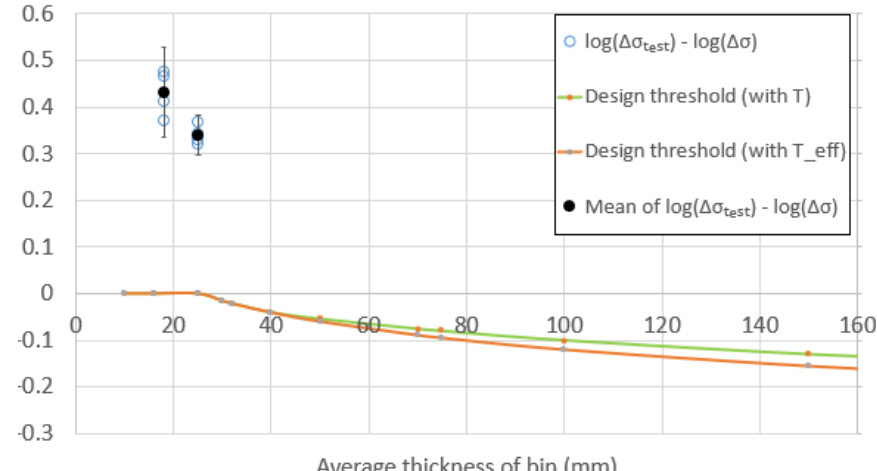
Figure 18. Data analysis of FC transverse butt-welded joints .